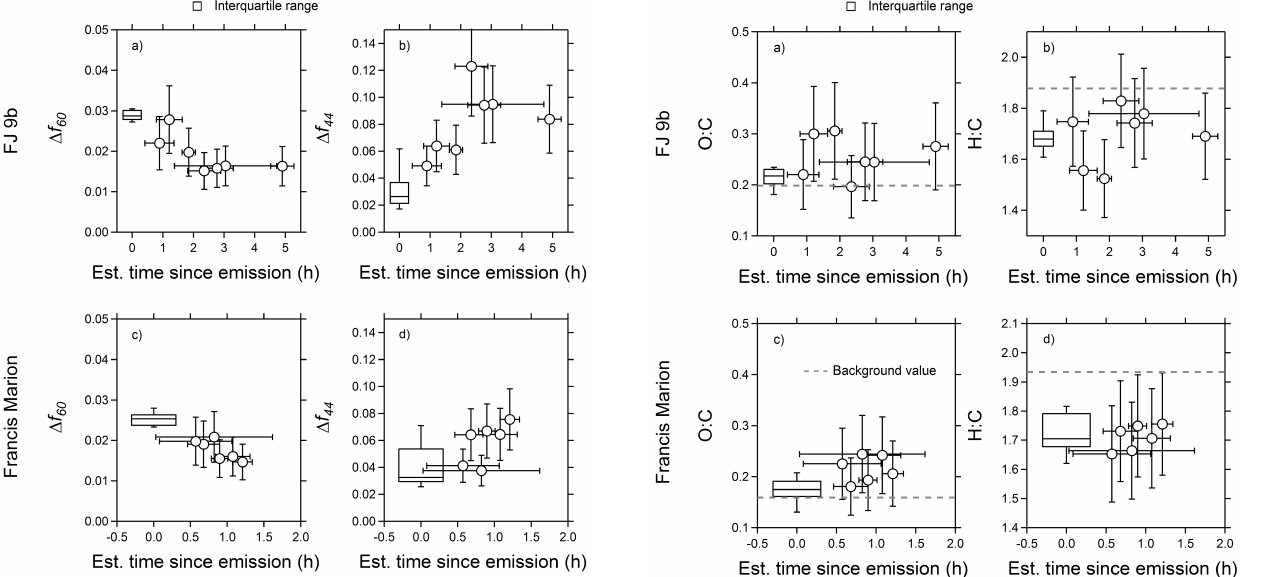
Figure 5. Evolution of elemental ratios derived from AMS data. (a) O:C for the FJ 9b fire; (b) H:C for the FJ 9b fire; (c) O:C for the Francis Marion fire; (d) H:C for the Francis Marion fire. For both fires, changes in O:C with increasing estimated time since emission are statistically significant. Dashed line is the value of the parameter in the background measurements outside of plume pen- etrations. Box-and-whisker plots and markers are used in the same way as those in Figs. 2 and